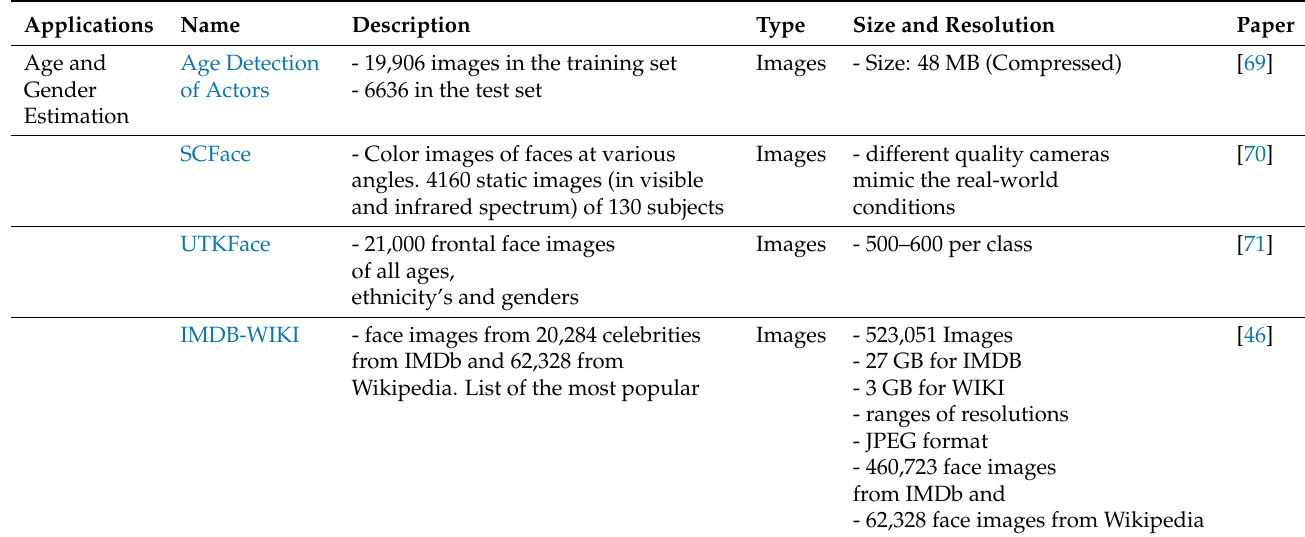
Table 6. Frequently used datasets.